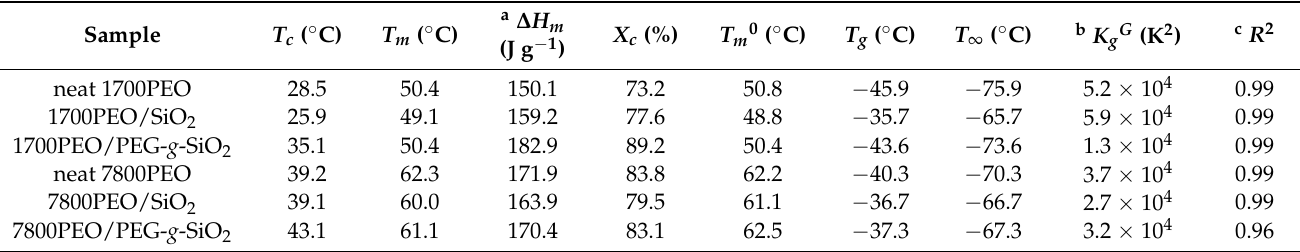
Table 1. Parameters related to the crystallization and melting behavior of the studied PEO nanocomposites. Sample